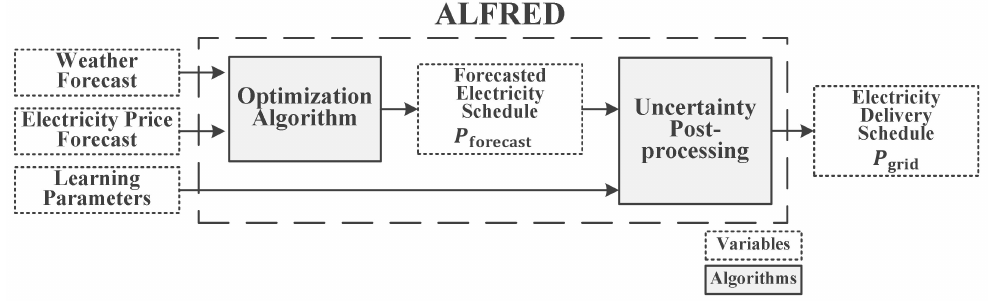
Figure 1. ALFRED (artificial learning flexible renewable energy system dispatch optimizer) dispatch planning tool scheme: partitioned strategy of optimization and uncertainty